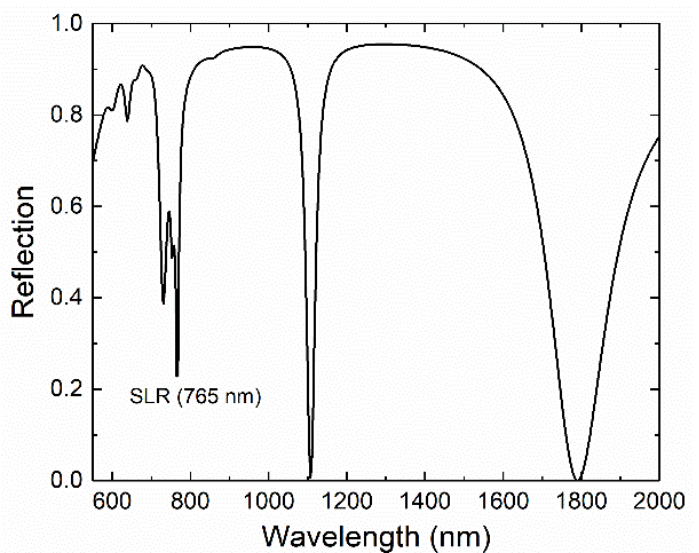
Figure 2. Simulated reflection spectrum as a function of the wavelength of the incident radiation. The sharp peaks at about 765 and 1107 nm correspond to the surface lattice resonance (SLR) of the Au inverted honeycomb lattice at the air–Au and Au–SiO 2 interfaces, respectively.